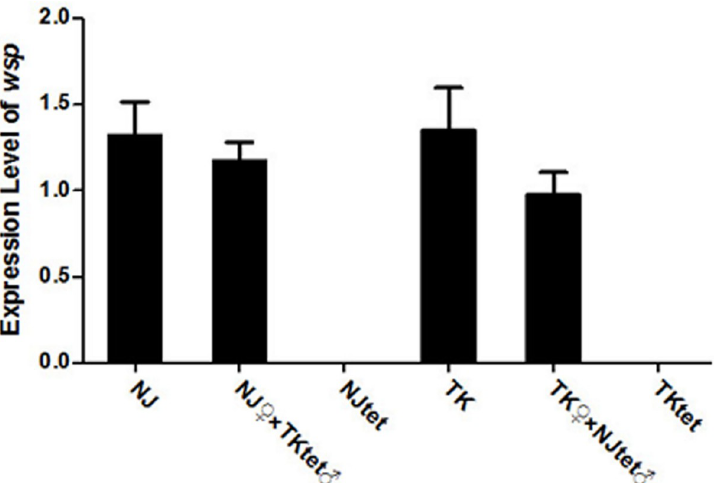
Fig 1. No significant change of Wolbachia density in hosts with hybrid genetic profiles. The expression of wsp gene was measured by real-time quantitative PCR in NJ ♀ × TK tet ♂ , TK ♀ × NJ tet ♂ , NJ tet , TK tet , NJ and TK virgin females at 2 days post-eclosion. wsp gene expression data were normalized with RPS6. The primer sequences are shown in Table 1. The bars indicate standard error. 2 − ΔΔ CT method was used to calculate the expression level. Significance was determined based on comparison of the Δ CT using Student’s